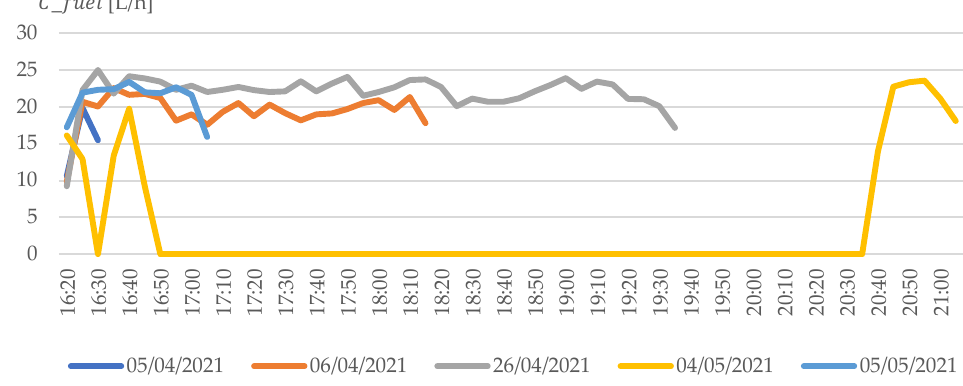
Figure 7. DGS monthly oil consumption based on Equation (2).